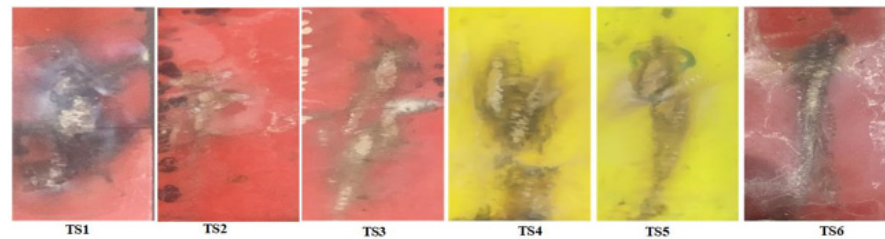
Figure 5. Tracking and erosion pattern of the aged samples.